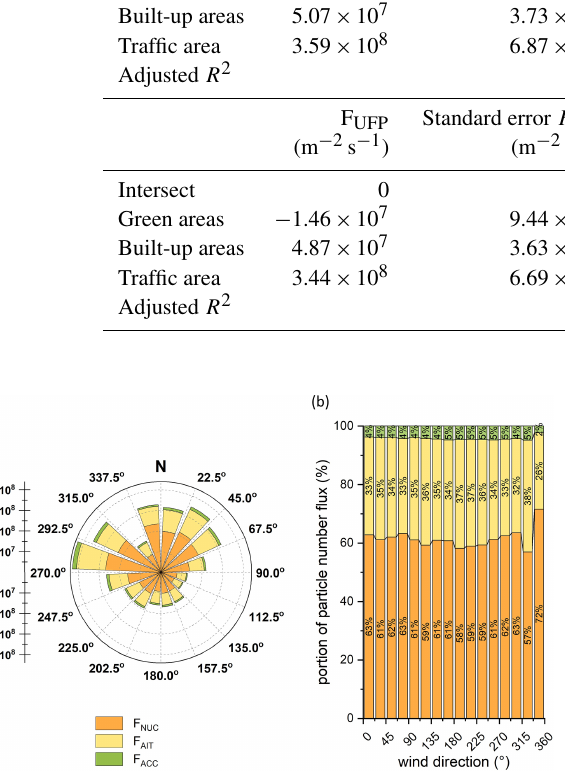
Figure 11. (a) Average particle number fluxes and (b) fraction of specific particle mode fluxes binned into 22.5 ◦ sectors for F NUC , F AIT , and F ACC